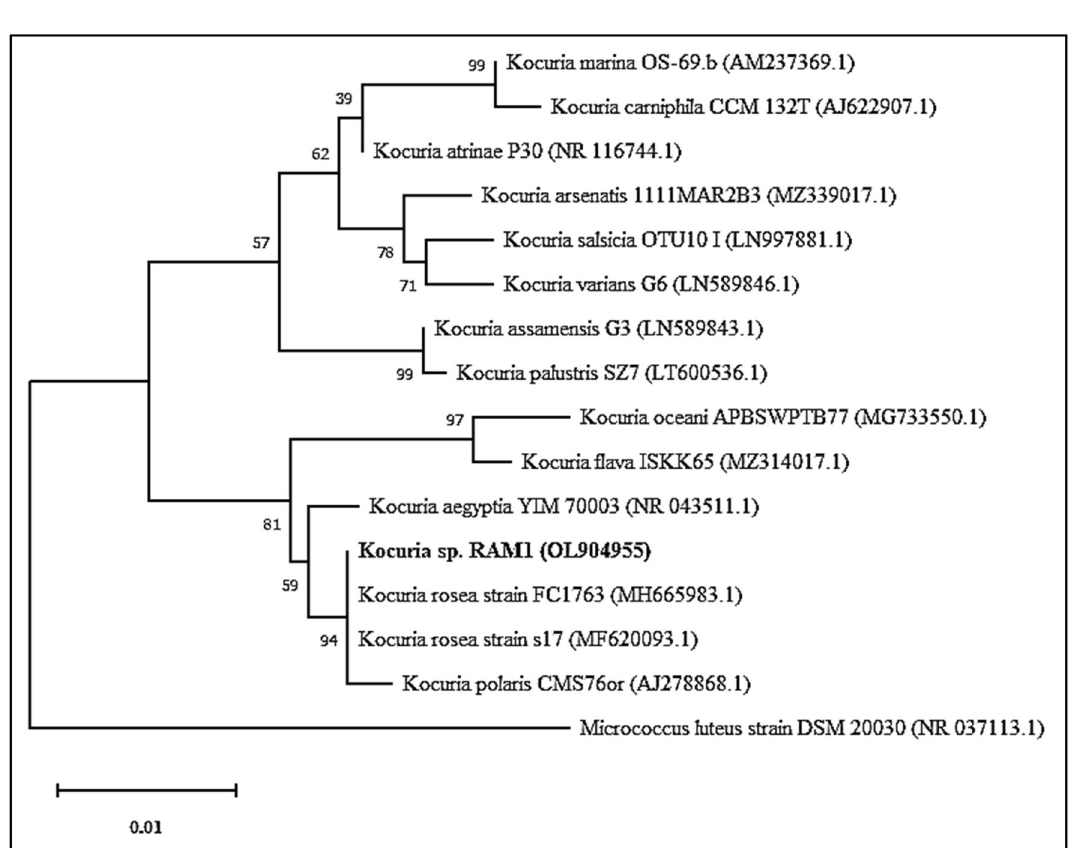
Figure 2. Phylogenetic tree of Kocuria sp. RAM1 estimated using maximum likelihood (ML). Kocuria sp. RAM1 was indicated by a bold style font. GenBank sequence accession numbers are indicated in parentheses after the strain names. The evolutionary analysis was conducted in the software package MEGA